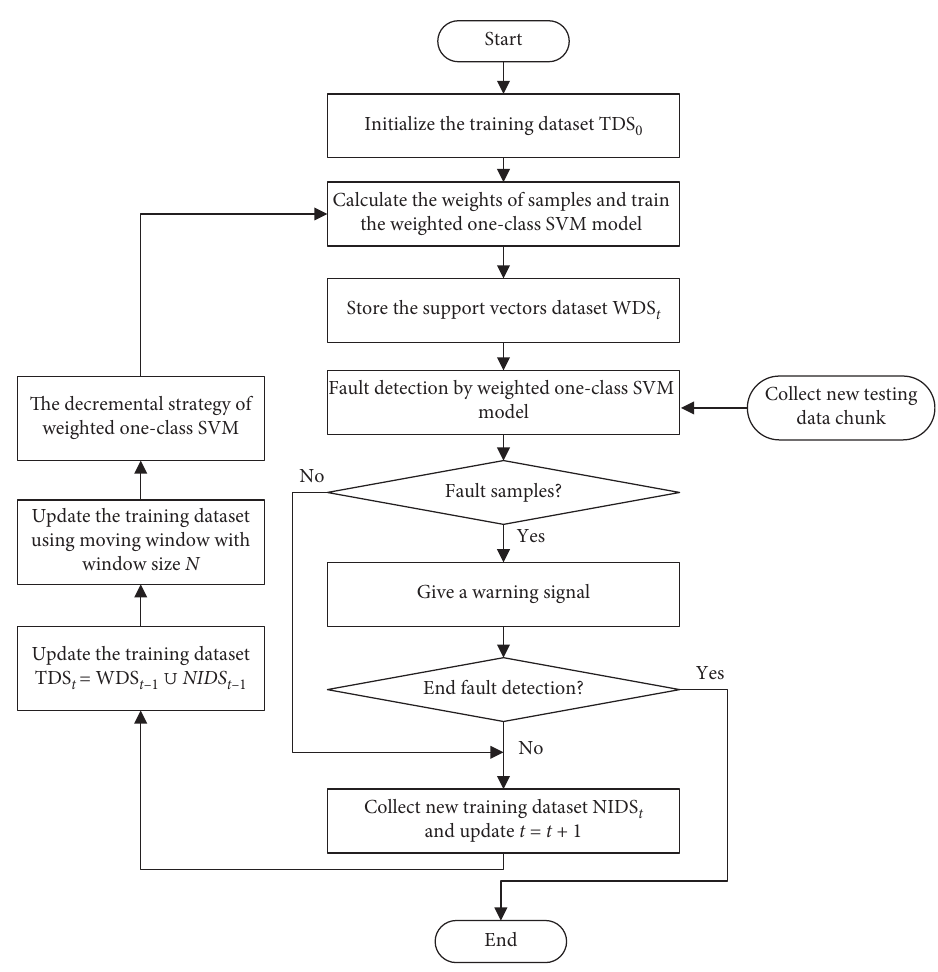
Figure 2: Flow diagram of the incremental